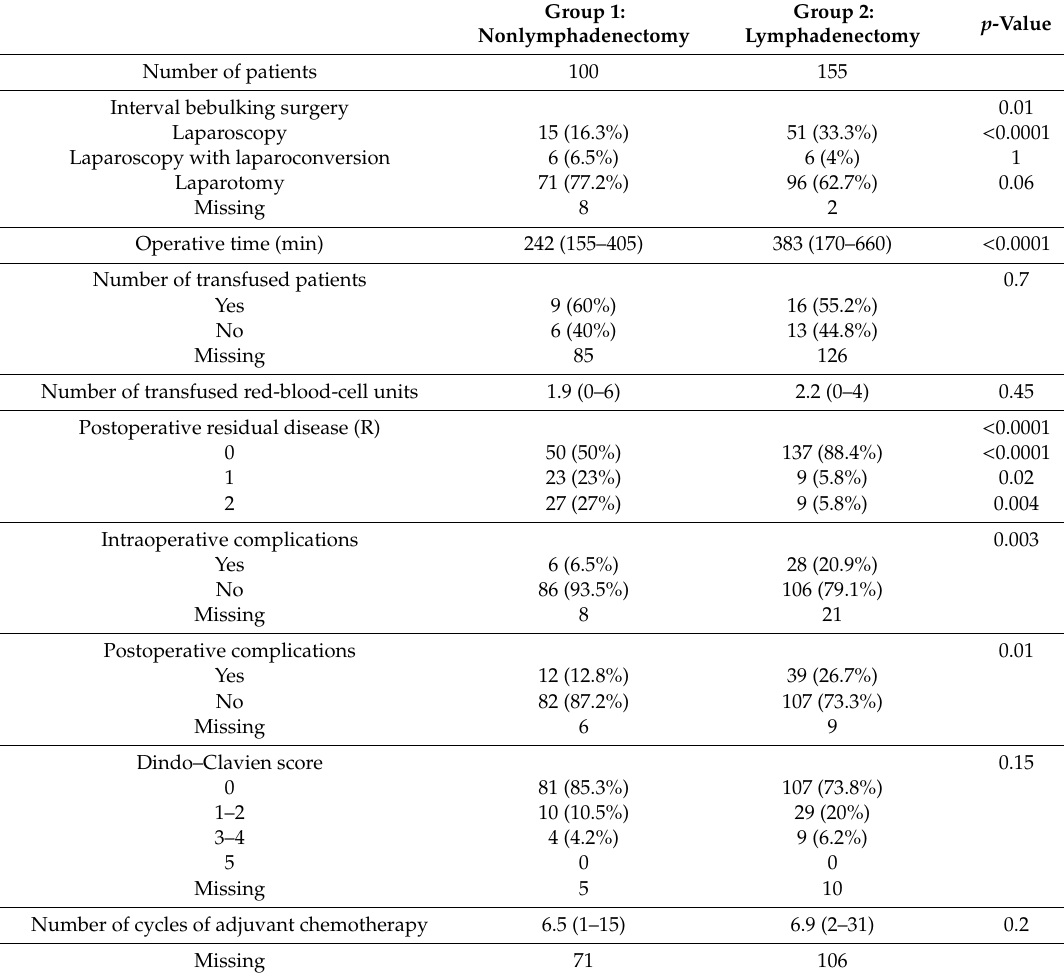
Table 3. Operative